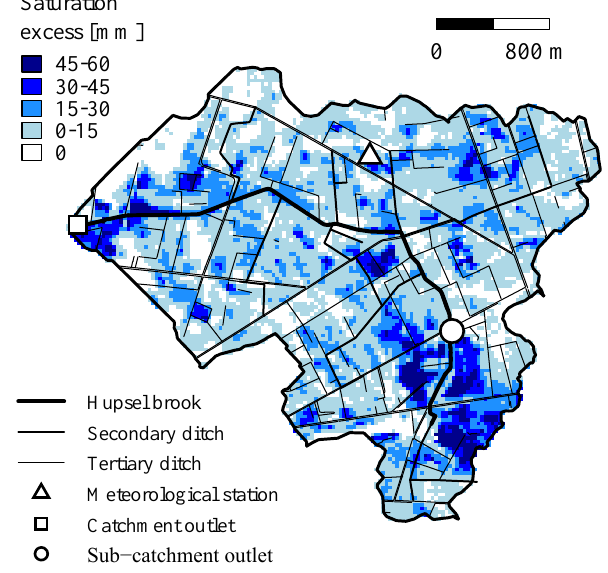
Fig. 9. Potential saturation excess, computed from the initial groundwater level, a specific storage of 10% and the total amount of rainfall of